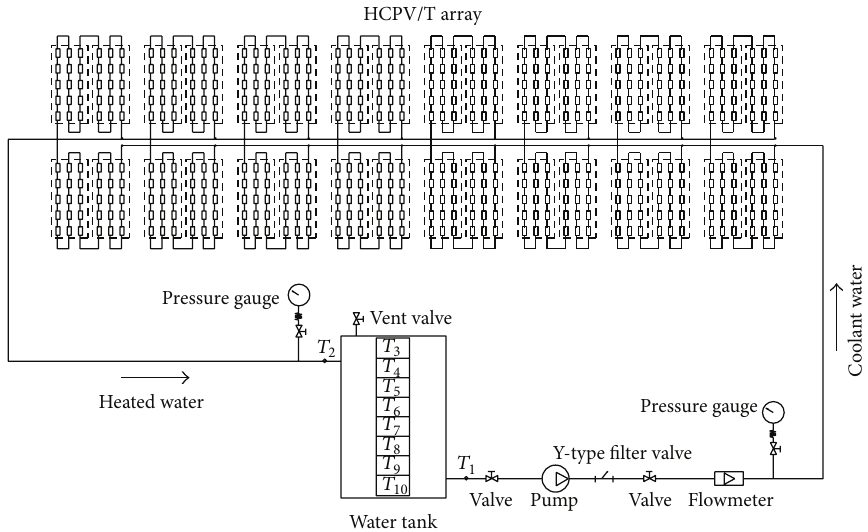
Figure 5: Schematic of water circulation and measuring point positions.